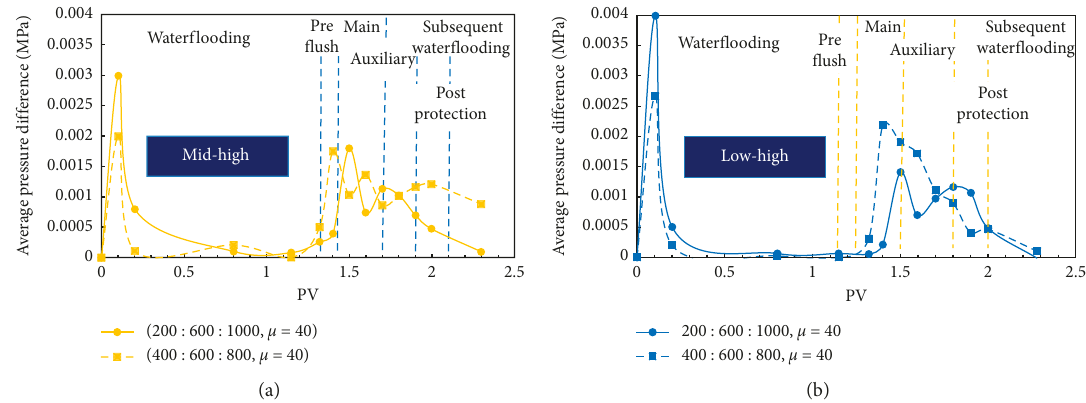
Figure 18: Average pressure difference curve. (a) Average pressure difference between the middle and the high permeability layer. (b) Average pressure difference between the low and the high permeability layer.